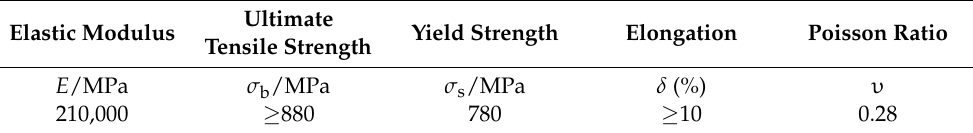
Table 2. U71MnG rail steel mechanical properties parameter table.